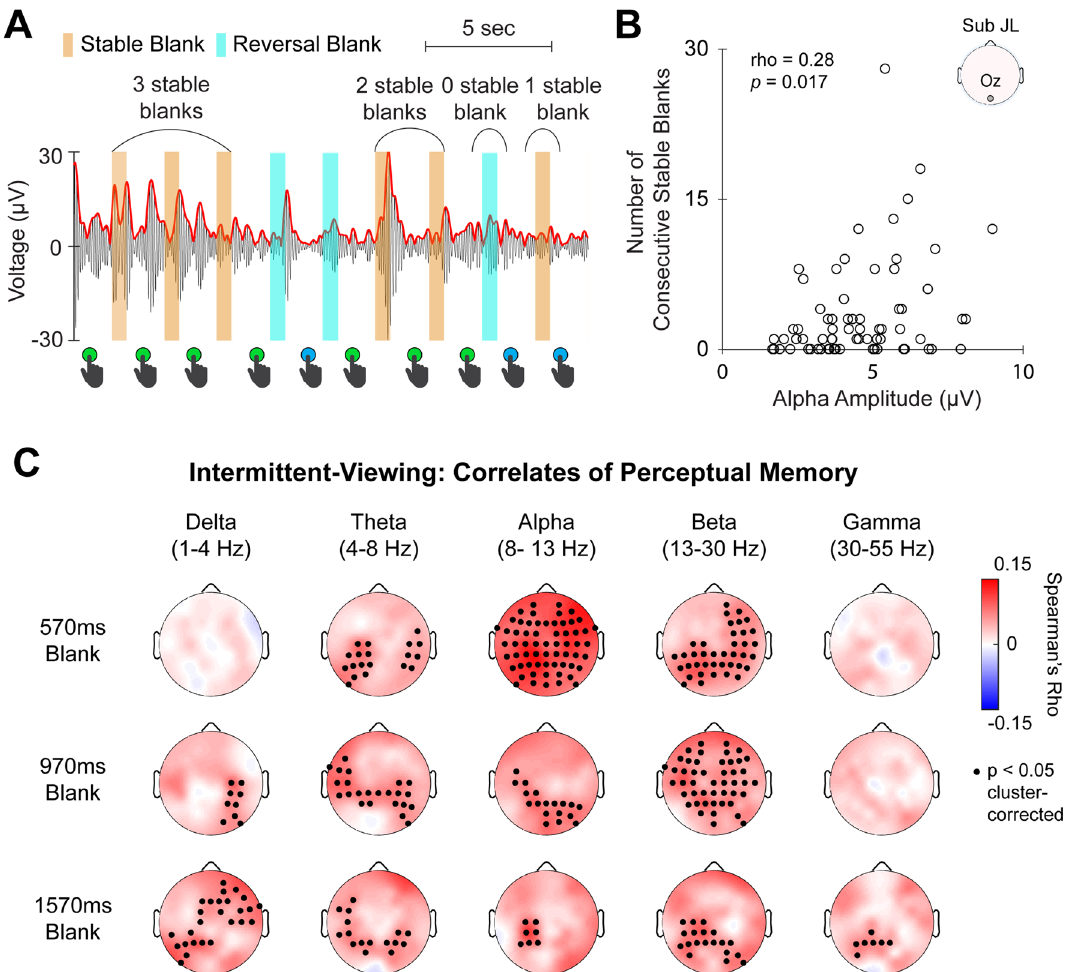
Figure 5. Alpha and beta amplitudes correlate with the persistence of perceptual memory. ( A ) The persistence of perceptual memory was assessed by the number of consecutive stable blank periods. The plot shows an example EEG recording over 20 s of an intermittent-viewing trial (black curve is signal filtered in the alpha band and red curve is its amplitude envelope) with its corresponding sets of consecutive stable blank periods. Stable blank periods are shaded in orange and reversal blank periods shaded in cyan. ( B ) Scatter plot shows all sets of consecutive stable blank periods and corresponding alpha amplitudes from channel Oz, for the cube trials from a single subject. ( C ) Spearman correlation was performed on each channel for each subject between the number of consecutive stable blanks and band-limited amplitude during the corresponding blank periods. Topo-plots show group-averaged Spearman rho values. Black dots indicate channels with significant Spearman correlation (cluster-based permutation test using Fisher-z-transformed rho values, N = 23, p < 0.05, two-tailed). Only data for cube trials are shown here (see Fig. S6 for face-vase